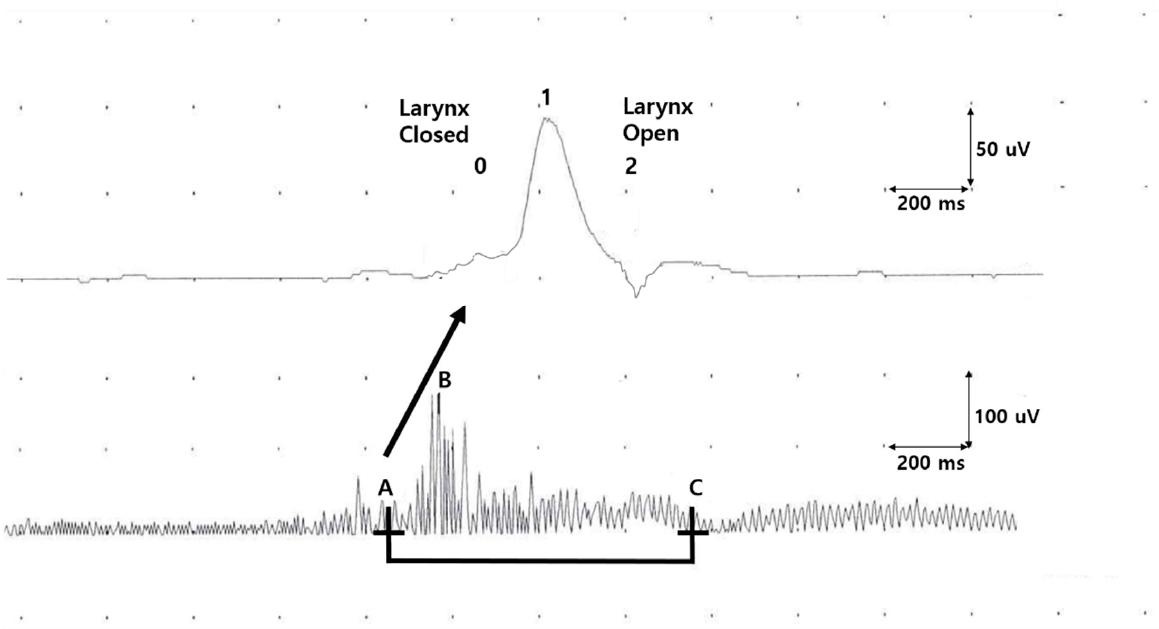
Figure 2. Evaluation of oropharyngeal swallowing function. An example of laryngeal movement signal (above) and submental electromyography (SM-EMG, below). “0” and “2” indicate the two subsequent deflections of laryngeal movement. “0” reflects the first deflection, which occurs with larynx and airway closure, and “2” reflects the second deflection with larynx opening. “1” indicates the point at which laryngeal movement reaches its maximum. “A” indicates the onset of SM-EMG signal, “B” indicates the peak amplitude of SM-EMG signal, and “C” indicates the end of SM-EMG signal. Based on these parameters, the laryngeal relocation time (“0”-“2” interval), triggering time (A-“0” interval), and total duration of SM-EMG (A–C interval) are depicted.